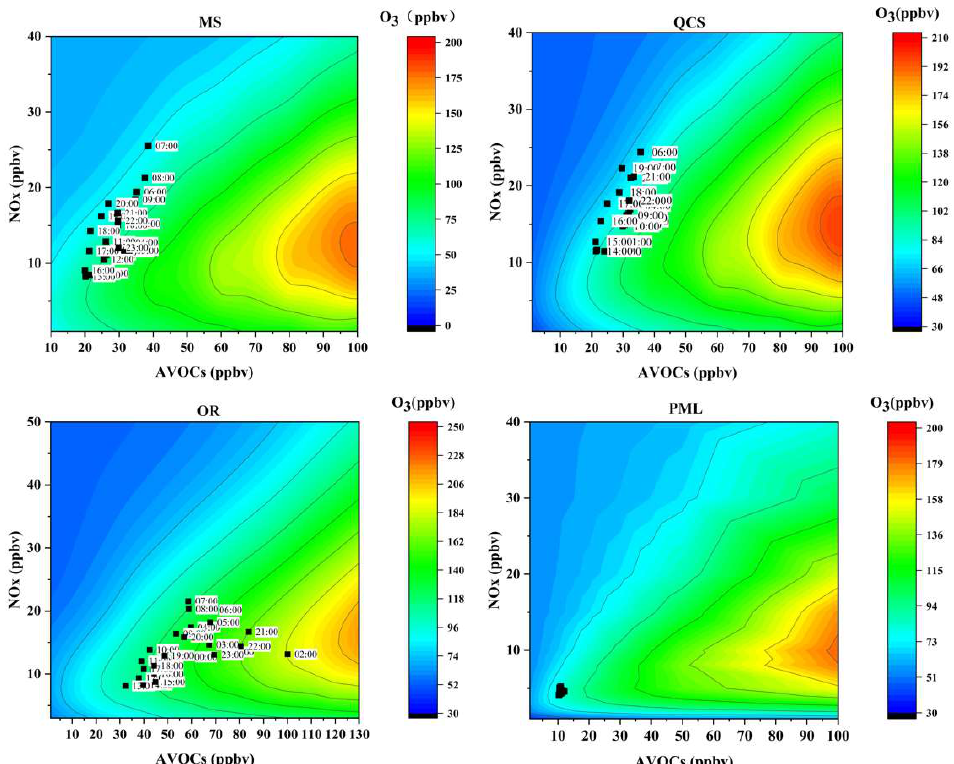
Figure 8. Empirical kinetics modeling approach curves for each site during the observation period. (The black dots represent the location of the daily average volume fraction of the VOCs and NO x during the observation period).